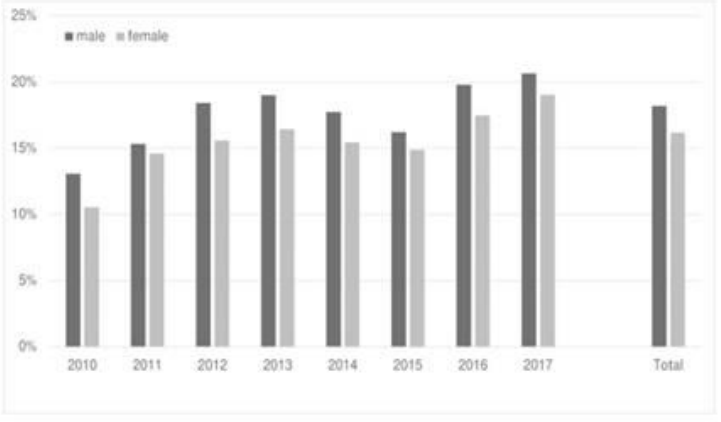
Figure 3. Performed CT scans (male/female, %) to detect the diagnosis of appendicitis, 2010–2017 ( n =